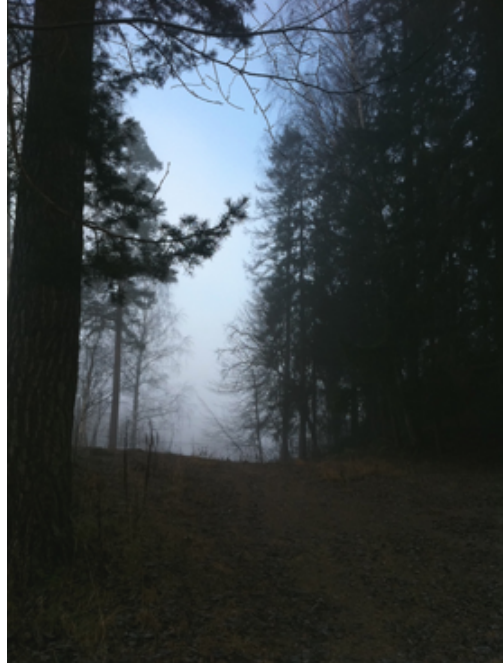
Figure 6. Unsafe/atypical nature (Study 2).